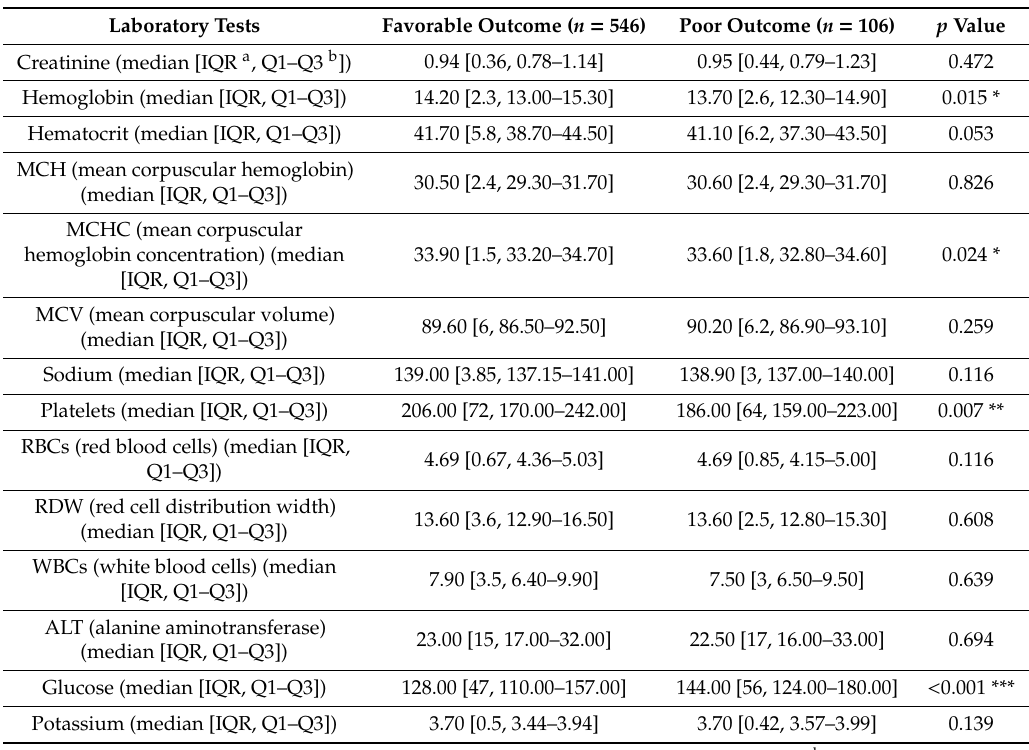
Table 2. Univariate analysis of the laboratory results.